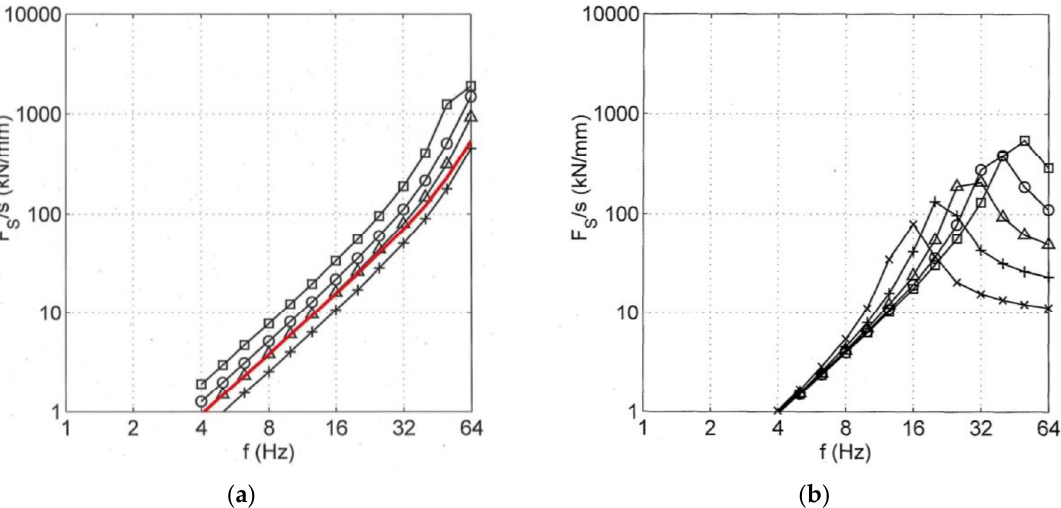
Figure 4. Transfer functions of vehicle–track interaction (dynamic axle loads due to irregularities) ( a ) for different wheelset masses m W = + 1000, ∆ 1500, ○ 2000, and □ 3000 kg, −− 1500 kg with H T ( f ) = 1, and ( b ) for different under-sleeper pads with stiffness of k P = × 10, + 20, ∆ 40, ○ 80, and □ 160 × 10 6 N/m.